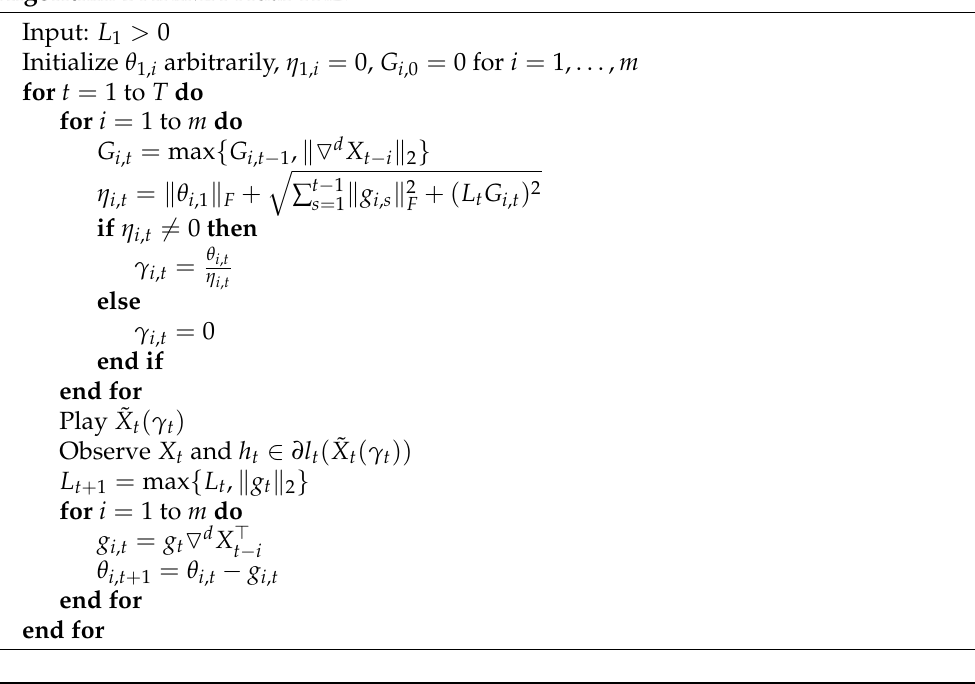
Algorithm 1 ARIMA-AdaFTRL.